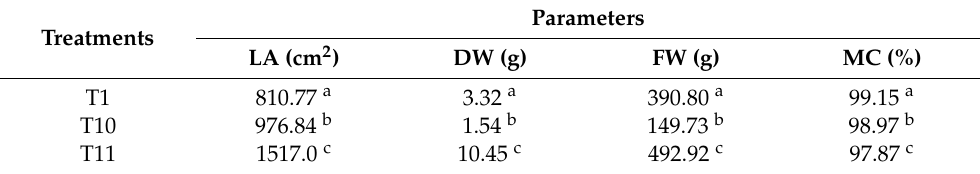
Table 8. The values of FW, DW, LA, and MC for T1, T6, T7, T8, and T9.